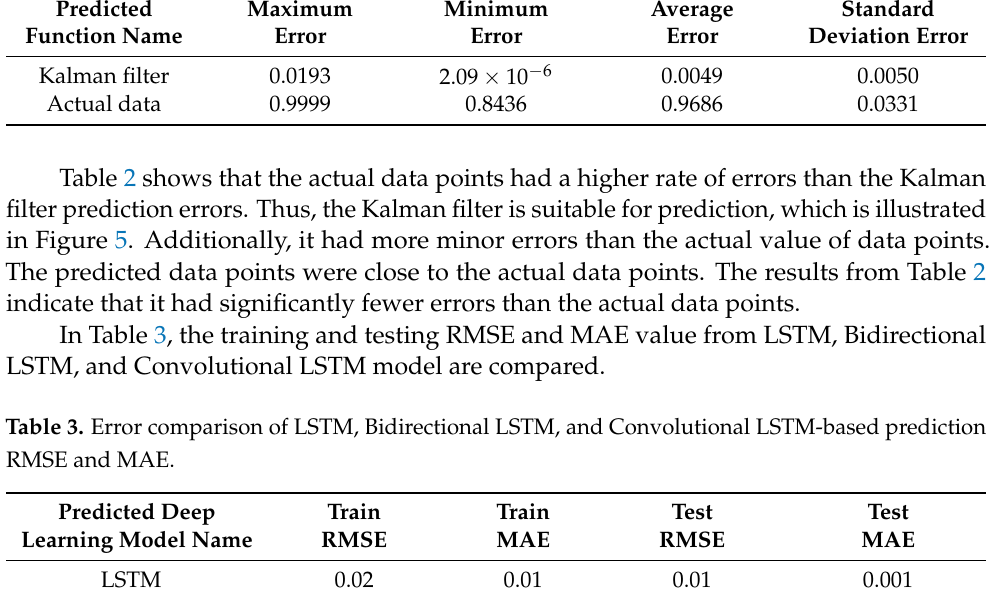
Table 2. Error comparison of Kalman filter predicted data and the actual data. Predicted